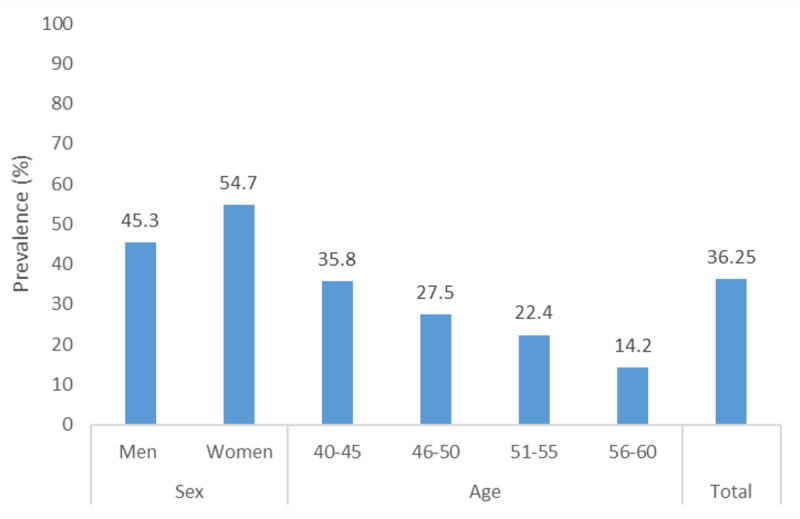
Prevalence of single chronic condition by sex and age.